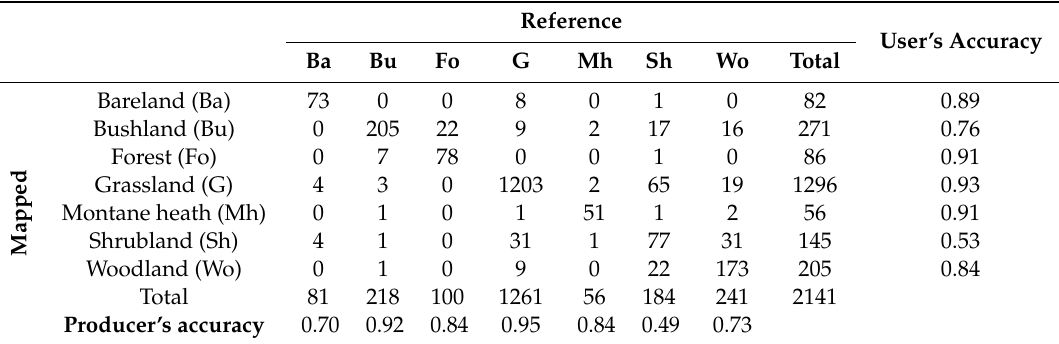
Figure 4. The overall accuracies and confidence intervals for the 21 model combinations tested. M1 to M7 include Sentinel-2 models; M8 to M14 include Sentinel-1 models and M15 to M21 include Sentinel-1 and -2 models. Coding of model combinations in Table 2. Table 3. Confusion matrix for the best performing model incorporating Sentinel-1 and Sentinel-2 data for both the dry and the short-dry season (i.e., Model